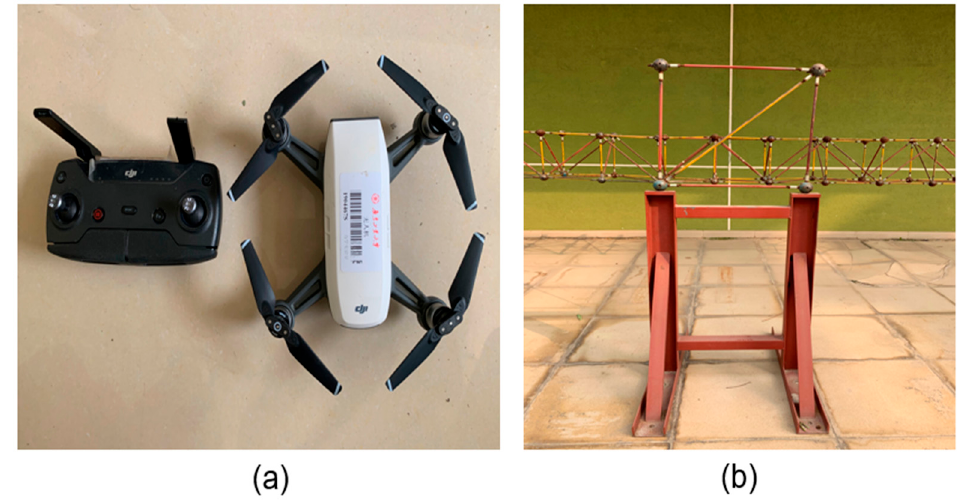
Figure 6. ( a ) DJI-Spark UAV; ( b ) fixed reference object.